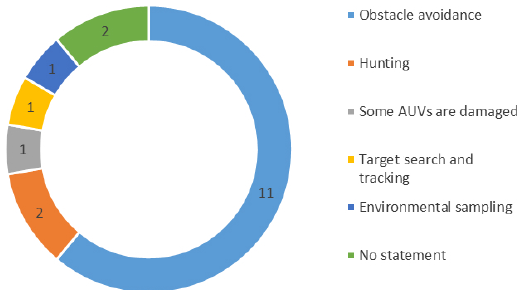
Fig. 8 Number of publications on formation transformation in different scenarios.